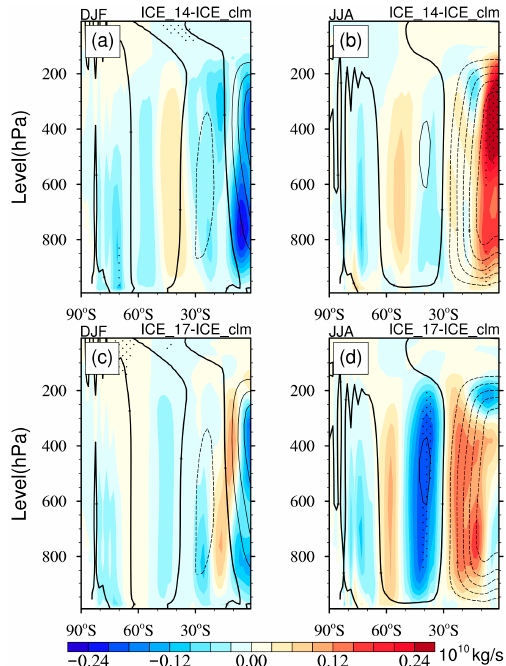
Figure 4. Changes in the zonal mean atmospheric meridional stream function as a result of changes in Antarctic sea ice. Differences between ICE_14 and ICE_clm in ( a ) summer and ( b ) winter. Differences between ICE_17 and ICE_clm in ( c ) summer and ( d ) winter. The dotted areas were statistically significant at the 95% confidence level. The contours represent the mean state of ICE_clm. For ICE_17, there was no change in the zonal mean of the temperature and the zonal wind in summer (Figure 3e,g) and no change in the three-cell circulation (Figure 4c). In winter, there was significant warming in the lower troposphere between about 55° and 65° S (Figure 3f), but the intensity was weaker than the cooling in ICE_14. There was a small, but significant amount of cooling in the mid-troposphere around 30° S in winter. The decreased temperature gradient from the subtropics to the pole weakened the west- erlies south of 30° S and the increased temperature gradient from the tropics to the sub- tropics strengthened the westerlies north of 30° S in the mid- to upper troposphere (Figure 3f). This suggests an equatorward shift in the subtropical jet, corresponding to a weakened Ferrell cell and a contracted Hadley cell (Figure 4d). In contrast to the results from previ- ous atmospheric models showing non-significant responses to decreasing Antarctic sea ice [19] or responses that were constrained to mid- and high latitudes [20], our model showed significant changes in the subtropical zonal winds in winter. 3.3. Changes in the Circulation in the Lower and Mid-Troposphere Figure 5 shows the changes in sea-level pressure and near-surface winds resulting from the extreme sea ice conditions. ICE_14 produced above-normal pressure over the Weddell Sea in summer (Figure 5a). As the height increased, there was above-normal pressure over the Bellingshausen Sea at 500 hPa (Figure S3a). There was a negative phase of SAM (not significant) at both the surface and at 500 hPa. This was consistent with an easterly anomaly centered at about 60° S (Figures 5a and S3a). In contrast, the responses in winter were zonal asymmetry and a wavenumber 2 pattern in both the lower and mid- troposphere between about 40° and 70° S. There was below-normal pressure in the